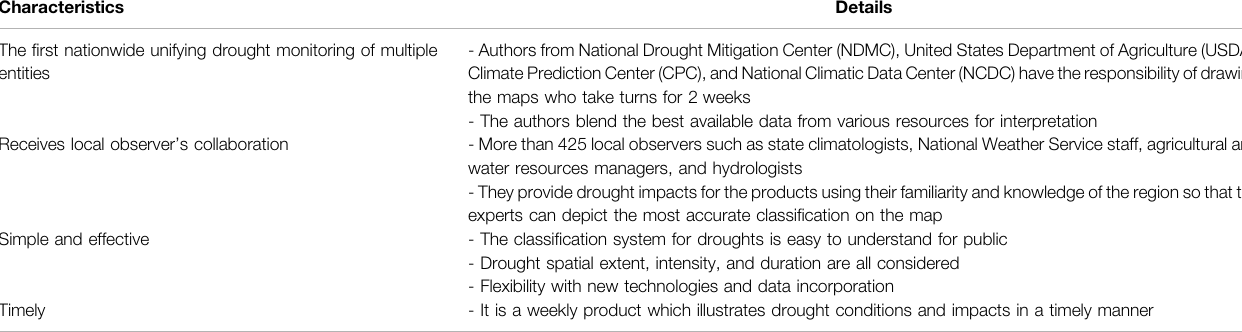
TABLE 1 | Uniqueness of the US drought monitoring (droughtmonitor.unl.edu, 2019; Svoboda et al., 2002).